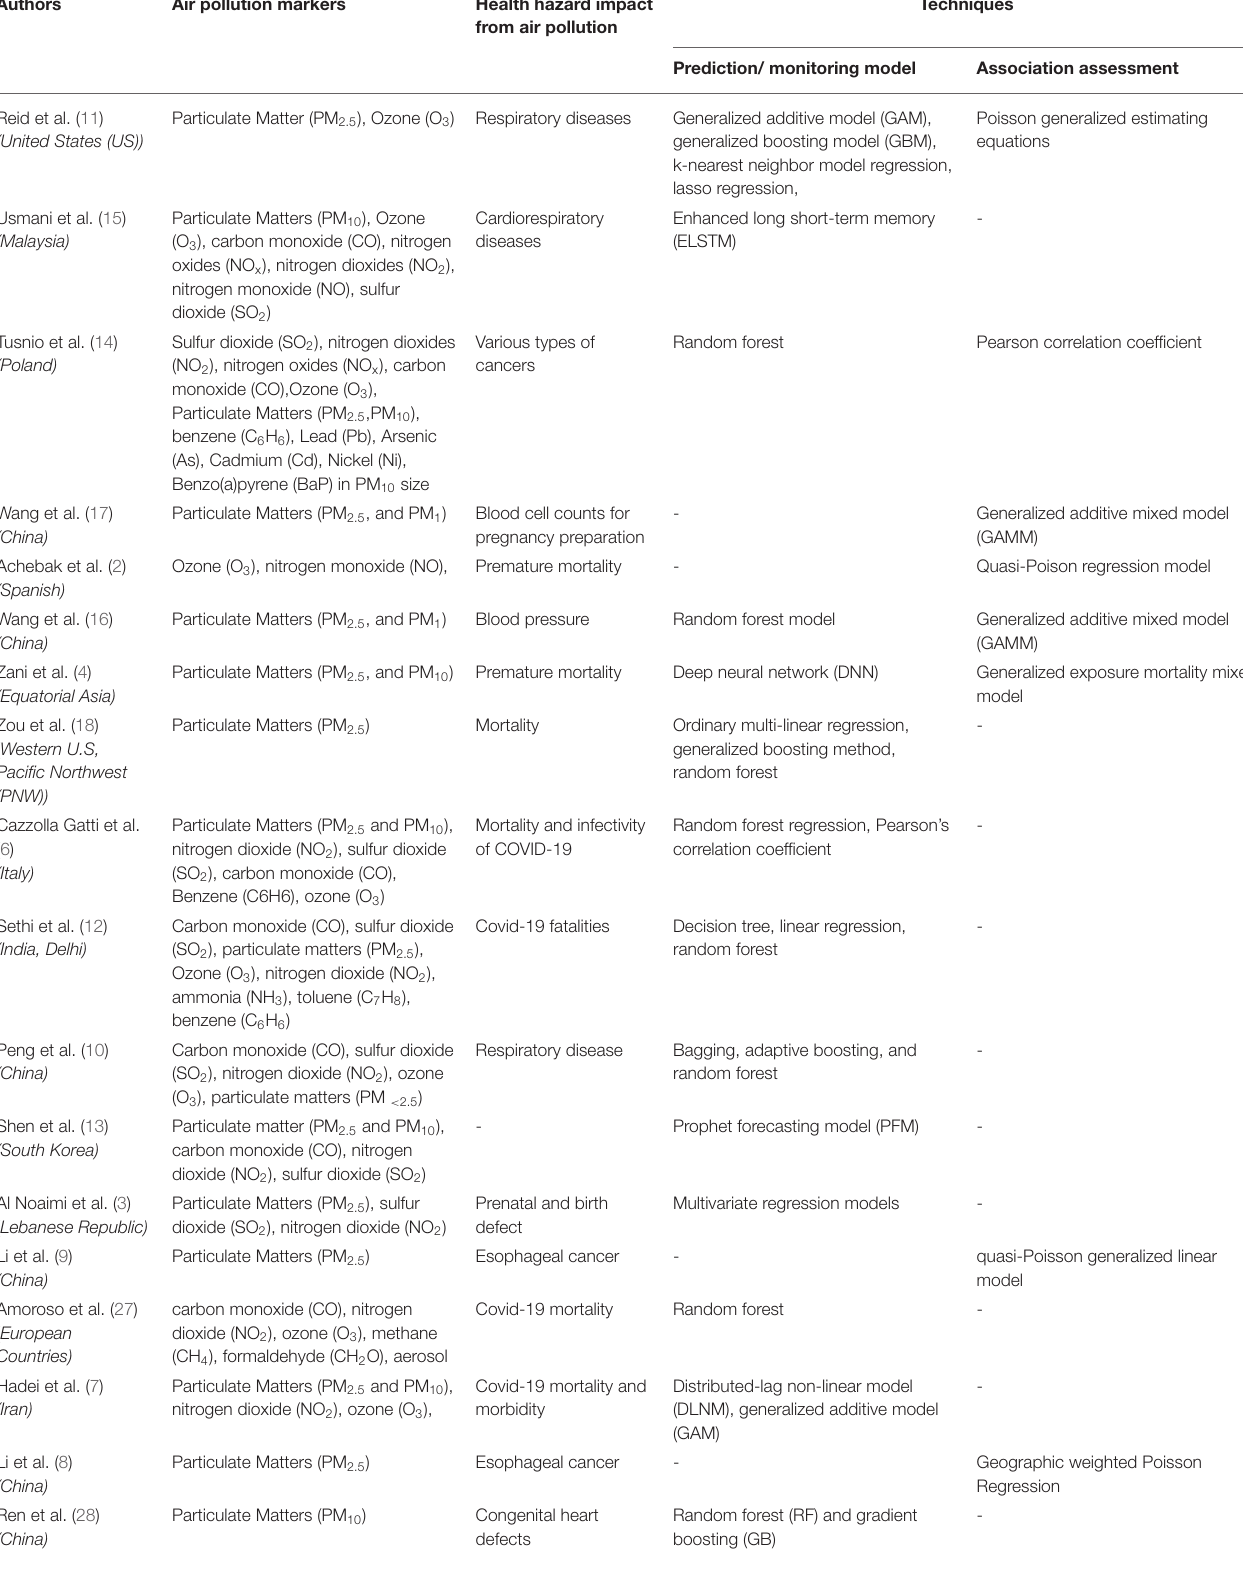
TABLE 4 | Summary and overview of the review